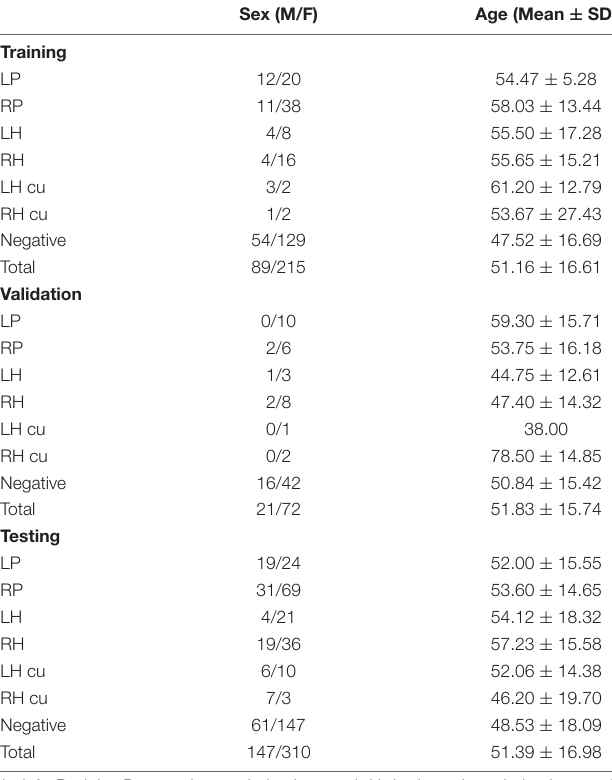
TABLE 1 | Summary of the data sets (baseline).